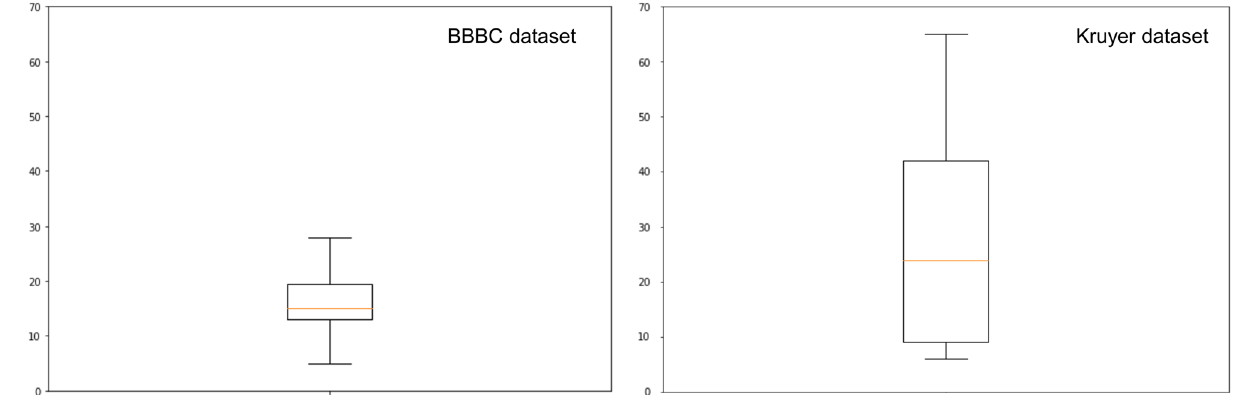
Figure 5. Cell count distribution. The boxplots show the different cell count distributions in the BBBC and Kruyer datasets. As usual, the box shows the interquantile range with the line inside indicating the median value.